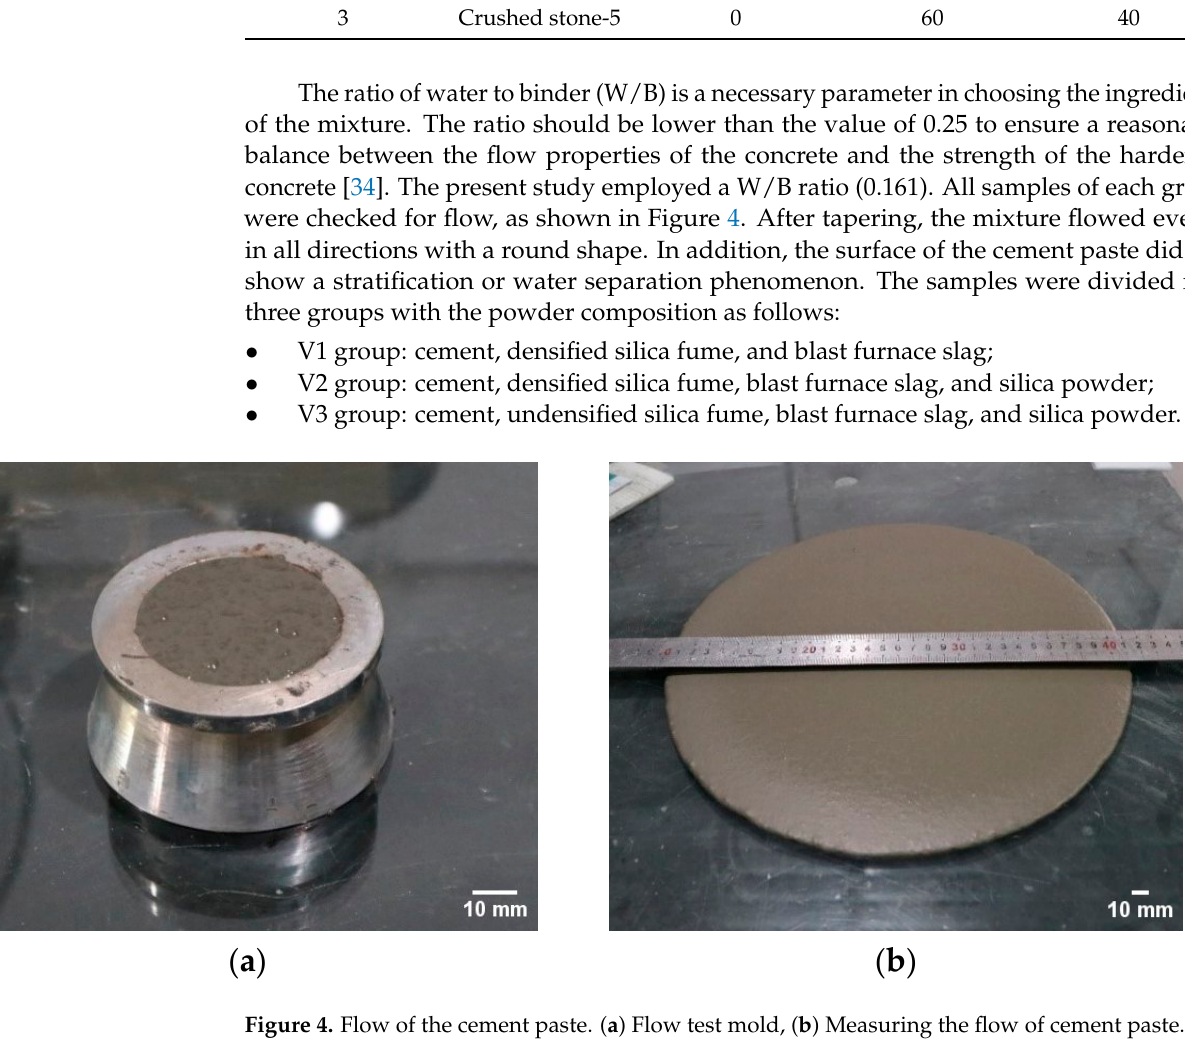
Figure 4. Flow of the cement paste. ( a ) Flow test mold, ( b ) Measuring the flow of cement paste. In the groups (V1, V2, and V3), the ratio of components was calculated based on the cement content, in which the silica fume is 10% of the cement content, and the superplasti- cizer is equal to 2% of the cement content. The total content of the silica powder and slag varied from 0 to 40% of the cement content. To examine the compressive strength, the prism samples (40 × 40 × 160 mm) were fabricated. The surface (40 × 40 mm) was subjected to a compressive load. Each group includes three cases relating to 3, 7, and 28 days. Each case has three specimens, as shown in Figure 5a. The specimens were under compressive load until the failure occurs. Figure 5b shows the shape of a sample after